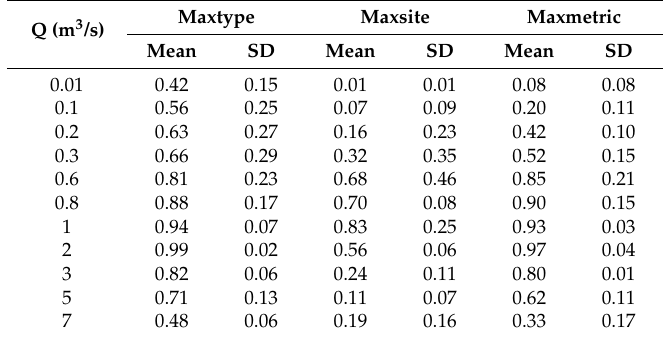
Table A3. Typological OFS means and standard deviations (SD) within the various κ -normalization alternatives for the Parapeiros reach. The OFS values of RM1-2 and RM4 types for each discharge (Q) have been averaged.